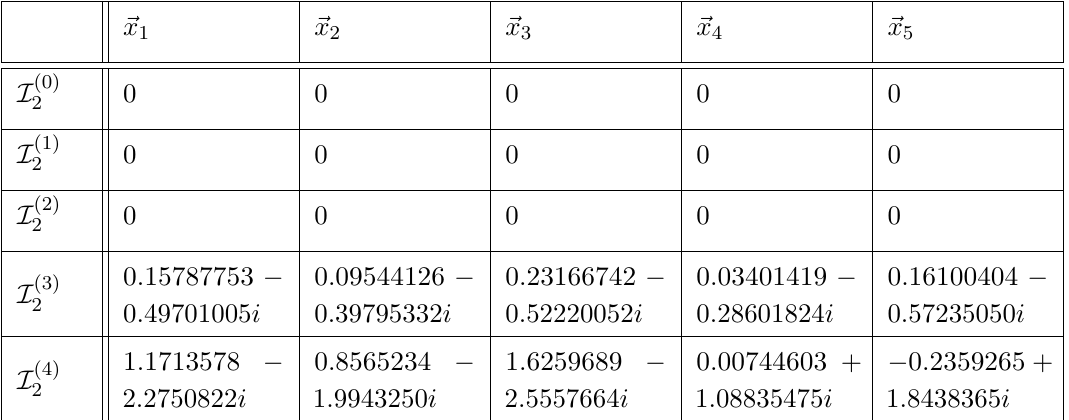
indicates the k -th 2